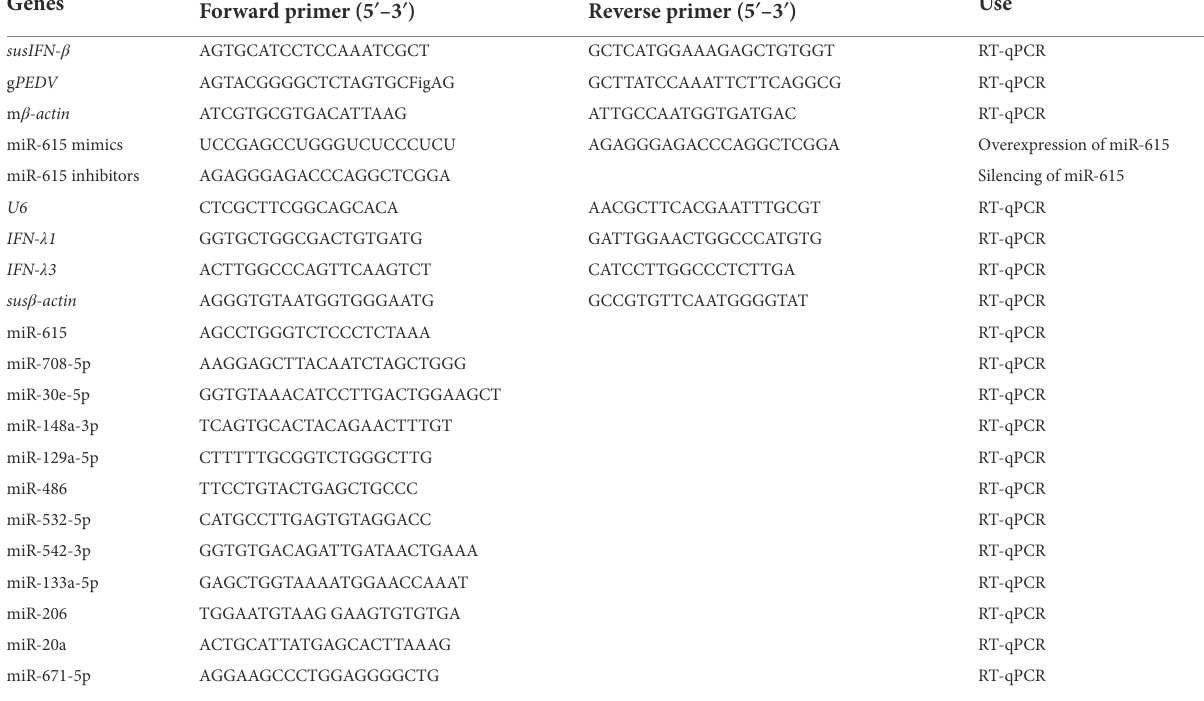
TABLE 1 Sequences of the miRNA mimic and inhibitor primers used in this study.